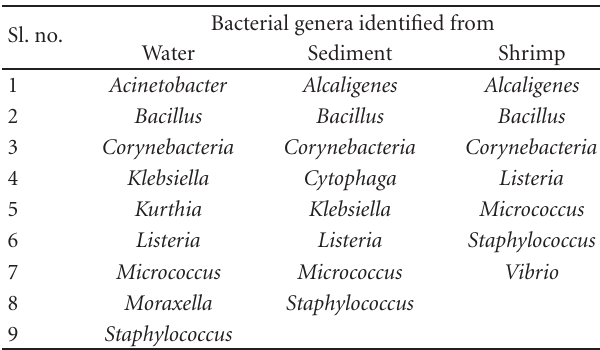
Table 3: Genera of heterotrophic bacteria identified from water, sediment, and shrimps in the feeder canal and shrimp